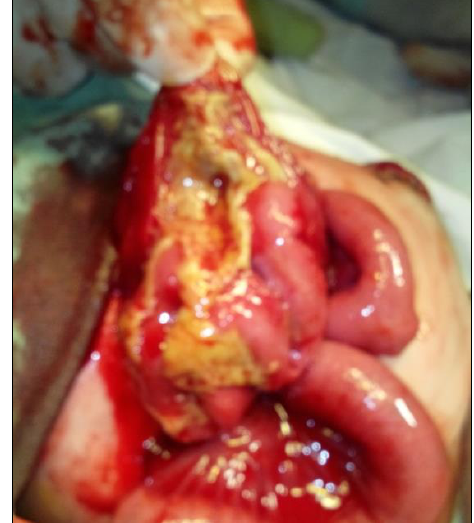
Figure 2: Gut loops dissected out of lesser sac.